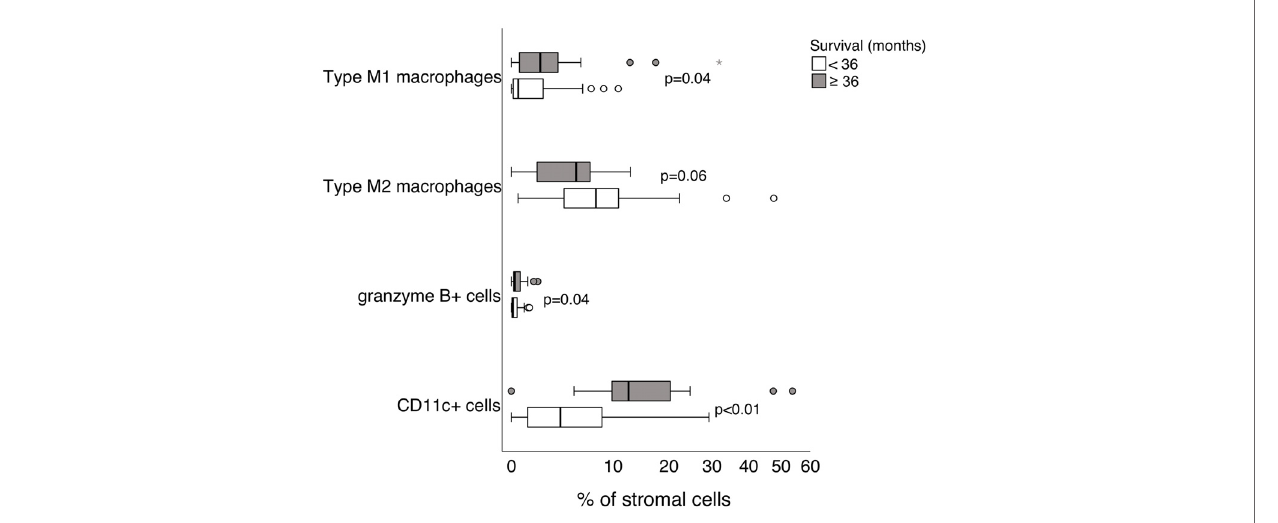
FIGURE 2 | The relative number (%) of each immune cell type of all stromal cells in long-term and average-term survivors (cutoff, 36 months). The cell classes that are signi fi cantly associated with survival in univariate Cox regression are shown. Differences between groups were tested by using the Mann – Whitney